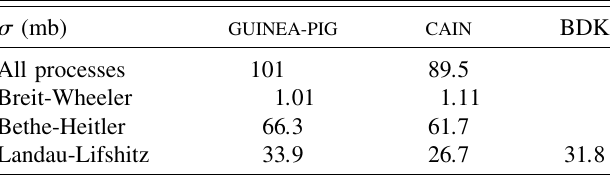
TABLE III. Cross sections for incoherent pair production without finite beam-size suppression effects in GUINEA-PIG , CAIN , and BDK